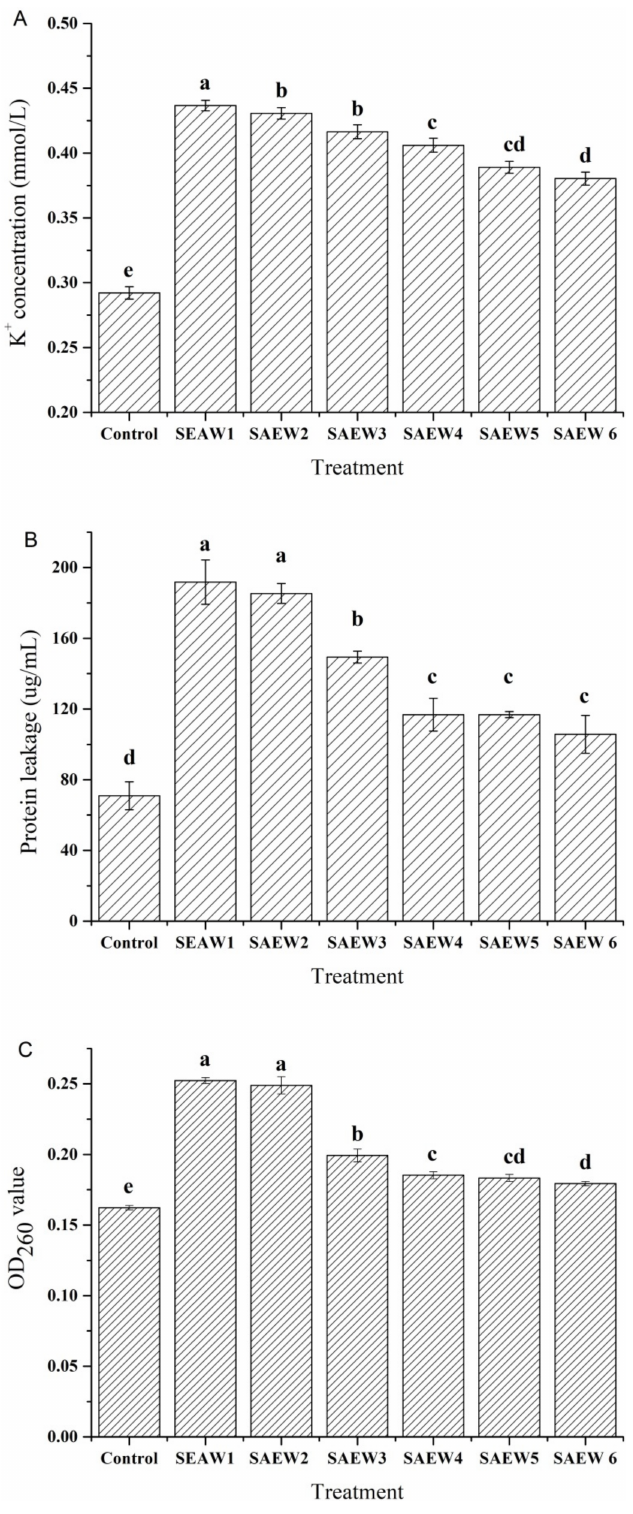
Figure 2. Effect of SAEW(slightly acidic electrolyzed water) on the leakage of intracellular material in L. monocytogenes including ( A ) K + concentration, ( B ) intracellular protein and ( C ) intracellular nucleic acid. SAEW with different ACC(available chlorine concentration.) were used for 60 s in the experiment and non-treated L. monocytogenes as control. Each experiment was performed in triplicate and data were presented as mean ± SD (standard deviation). Different letters on the top of the bar mean significant difference between different samples ( p <